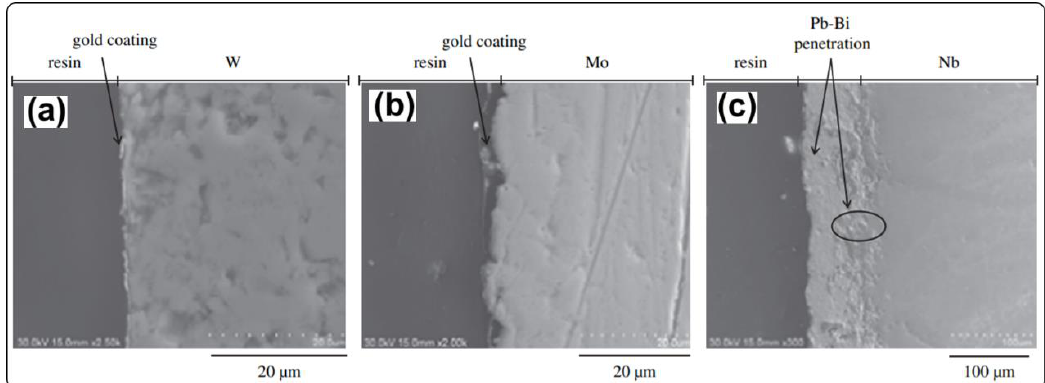
Figure 7. Cross-sectional morphology of refractory metals tungsten ( a ), molybdenum ( b ) and niobium ( c ) after 1000 h of corrosion in LBE at 700 °C [74]. Figure 7 is reproduced with permission from [74]. Copyright 2008 Elsevier.